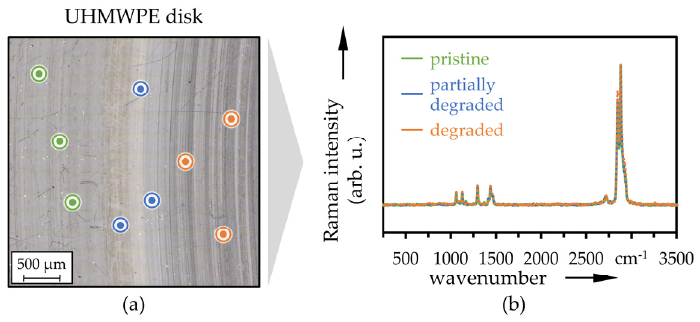
Figure 10. LM image with Raman measurement positions ( a ) and averaged Raman spectra ( b ) at pristine and degraded positions of the UHMWPE disk after sliding against the Ti64 pin ( n =